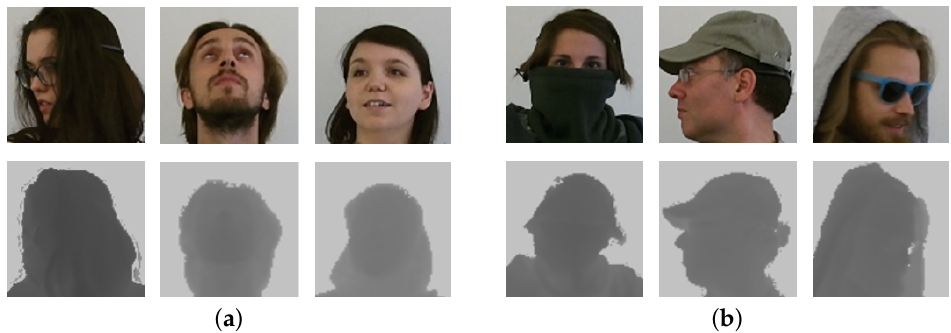
Figure 3. Sample depth and RGB frames taken from the Pandora [17] dataset. Frames from subsets S 1 , S 2 , S 3 are reported in ( a ), while frames from subsets S 4 , S 5 with garments and eye glasses are shown in ( b ). See Section 4.1 for further details about the subsets.